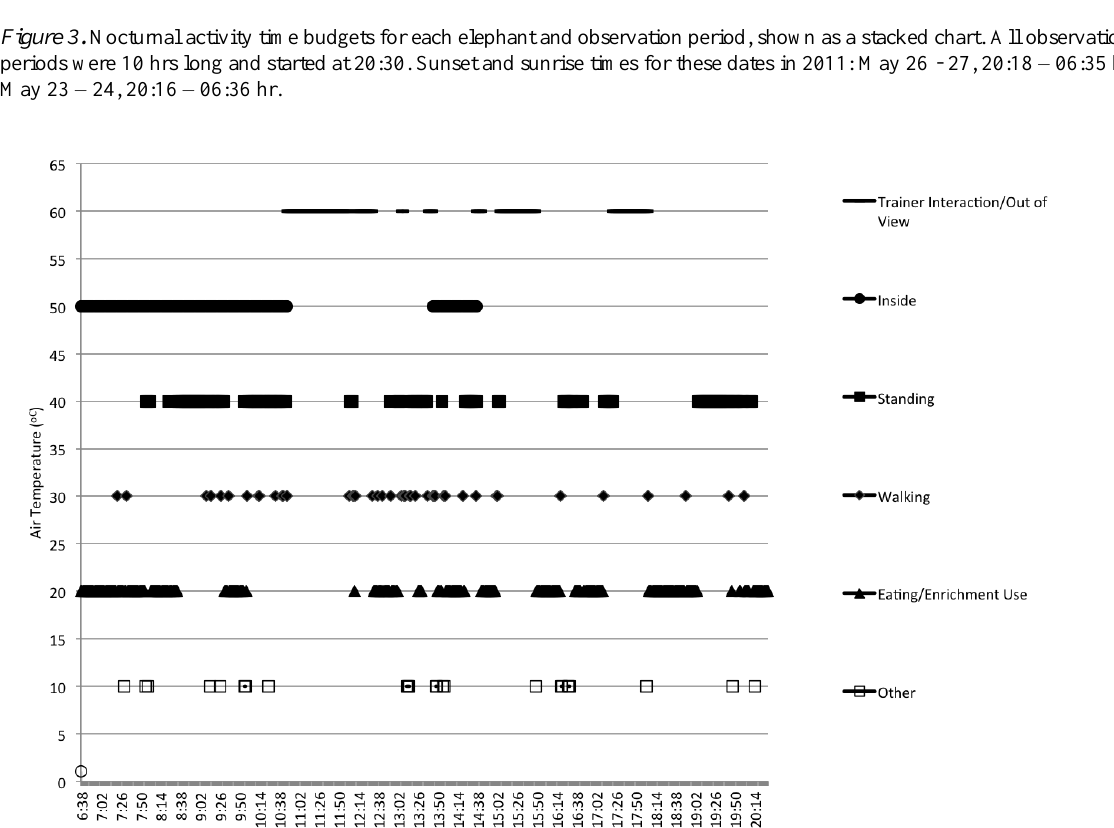
Figure 4. Sample diurnal ethogram, Elephant K on May 30,